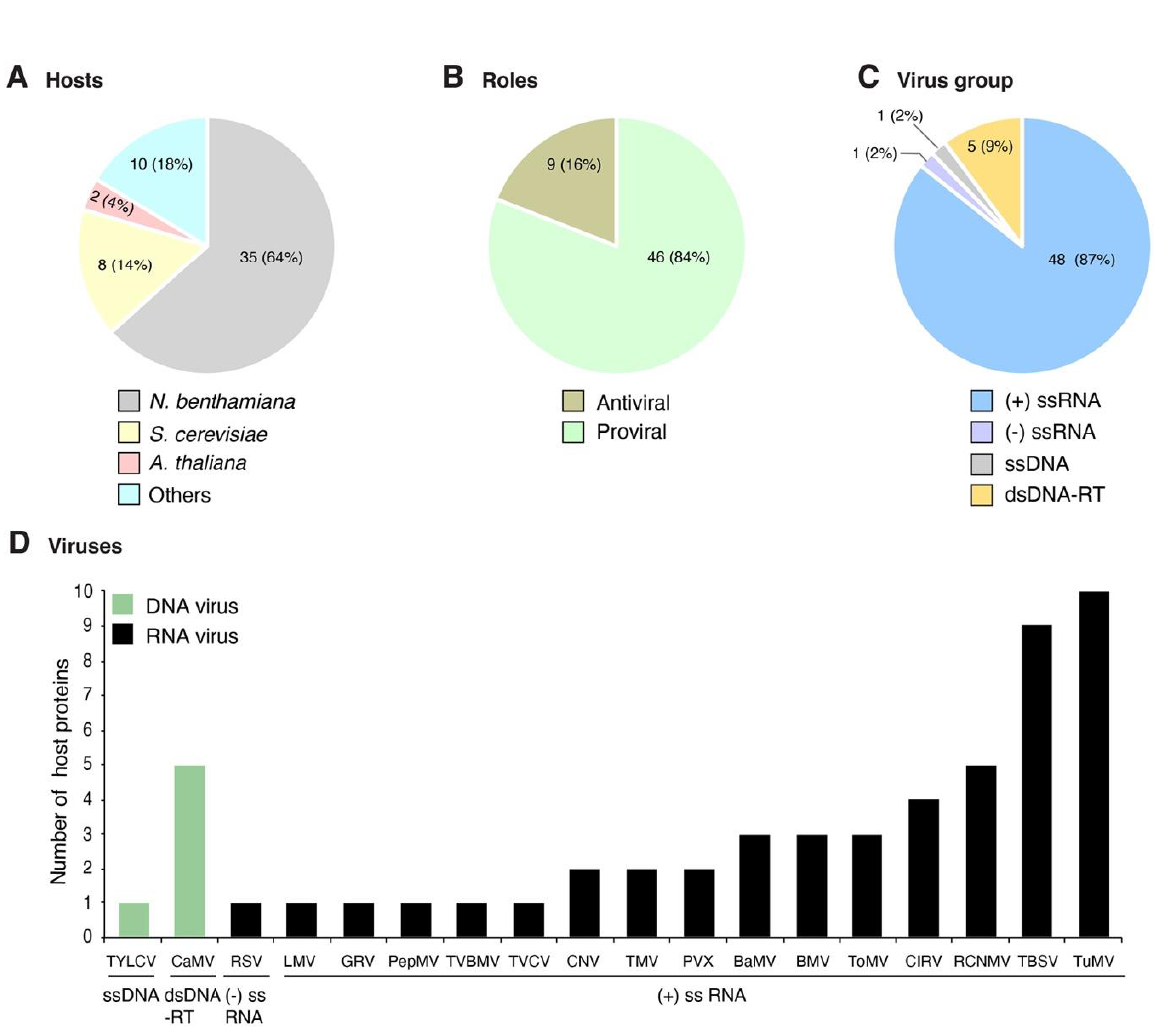
Figure 1. Profile of host proteins that change their subcellular localization during plant virus infection as reported in the literature. Fifty-five combinations of host protein-plant virus were documented in publications. ( A ) Number and proportion of proteins by host species. ( B ) Number and proportion of host proteins with antiviral role or beneficial to the virus. ( C ) Number and proportion of host proteins by virus group. ( D ) Number of host proteins by virus species. Viruses are grouped based on their genome organization .